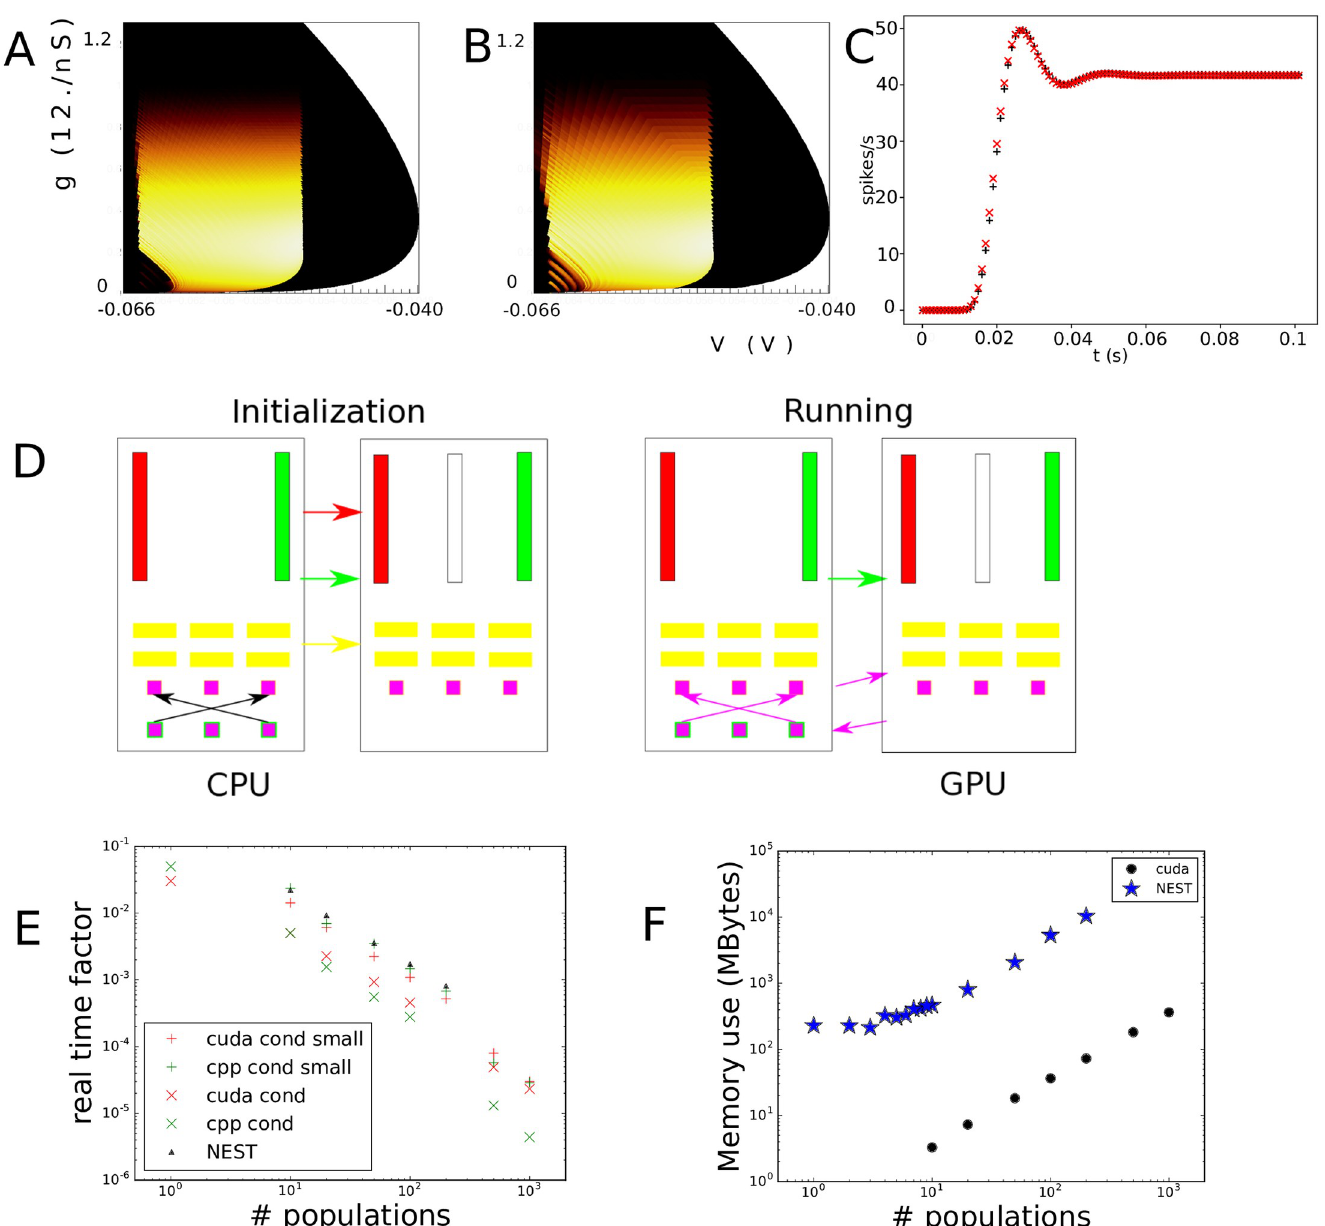
Fig 15. A-B: Comparison of the default mesh for conductance based neurons to a reduced mesh. Although coarser cells are visible in B, the density is not visibly affected, in particular in the white areas, where the bulk of the density is present. C: Firing rates are almost identical. D: Interaction between the C++ driver and the GPU registers, Interaction between CPU and GPU in a CUDA-based simulation. During the initialization, the mass array (red), the map array (green), the matrix elements (yellow) are copied onto the GPU. During simulation only the map (green) is updated in C++ and copied to the GPU, and firing rates are calculated from the meshes on the GPU. On the CPU the firing rates are processed by the network, and delays are applied where applicable. Resulting firing rates are sent back to the GPU for processing the the next simulation step. E: Run time factors for direct simulation, CUDA and C++ implementation (default and reduced mesh). F: memory use, NEST and CUDA